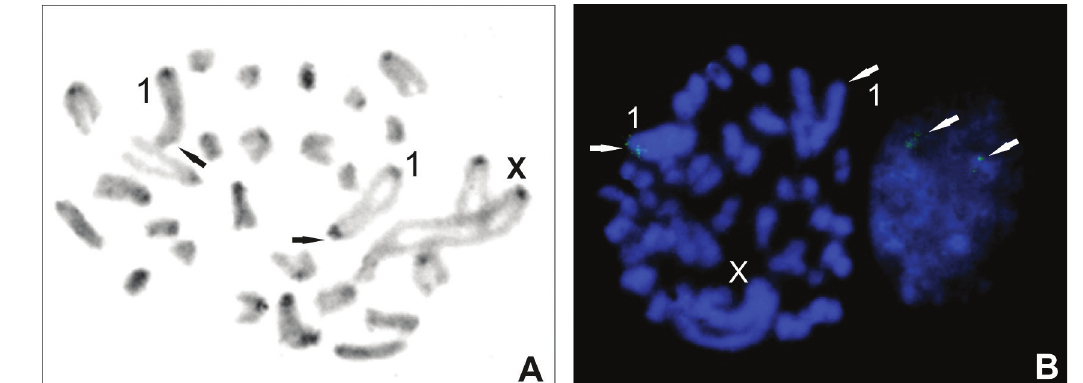
Figure 14. Male chromosomes of Ectadia diuturna sp. n. A. C-banded metaphase; B. FISH with 18S rDNA (green) probe in metaphase/ anaphase ( A – the left) and prometaphase ( B – the right). Arrows indicate telomeric located C-bands ( A ) and cluster of 18S rDNA ( B ) in the heteromorphic large-sized chromosomes (marked with “1”); X, sex chromosome.